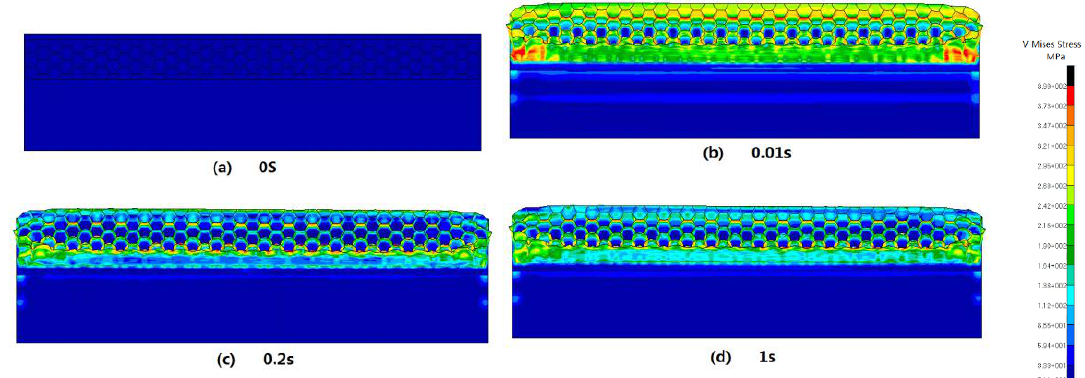
Figure 13. Stress distribution of the ARBW under impulse loads. ( a ) the moment of 0 s, ( b ) the moment of 0.01 s, ( c ) the moment of 0.2 s, ( d ) the moment of 1 s.